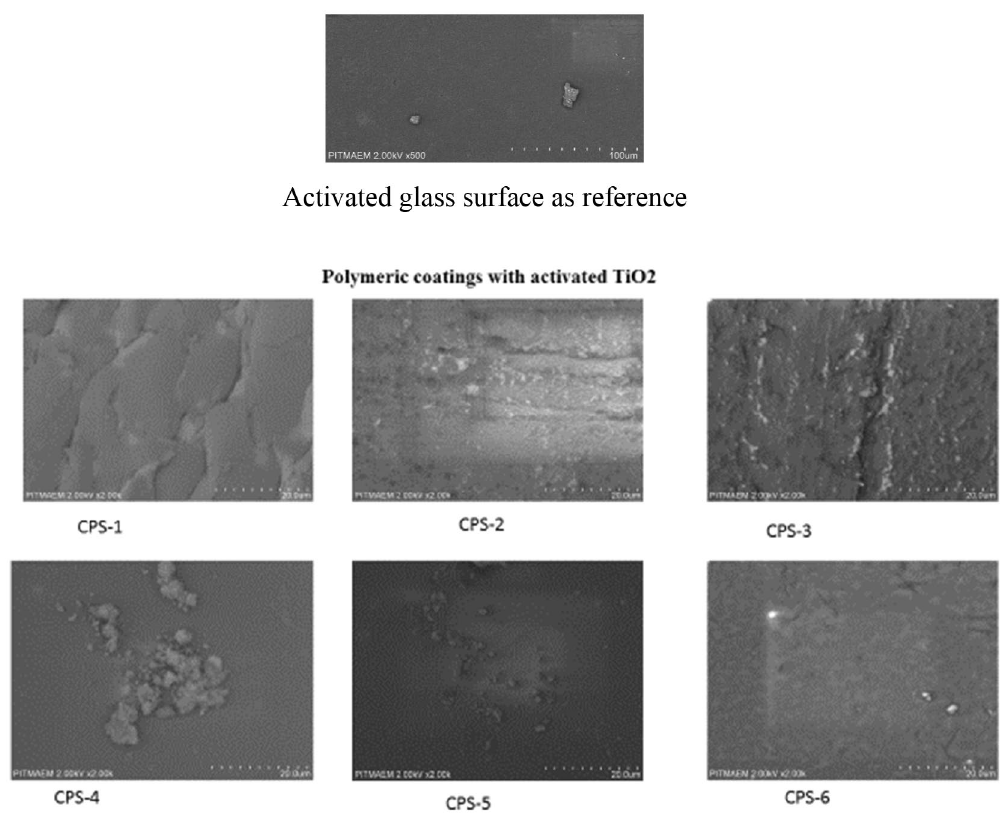
Figure 7. SEM analysis of coated samples.